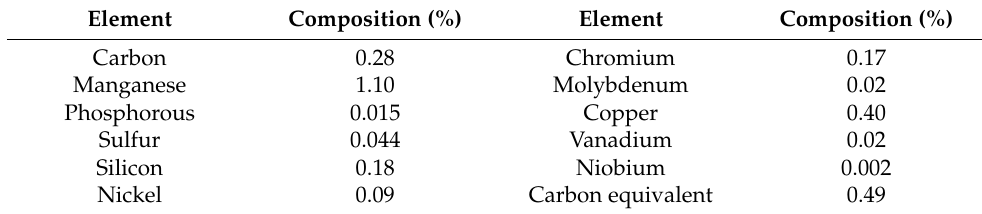
Table 2. Chemical composition of the steel rebar.